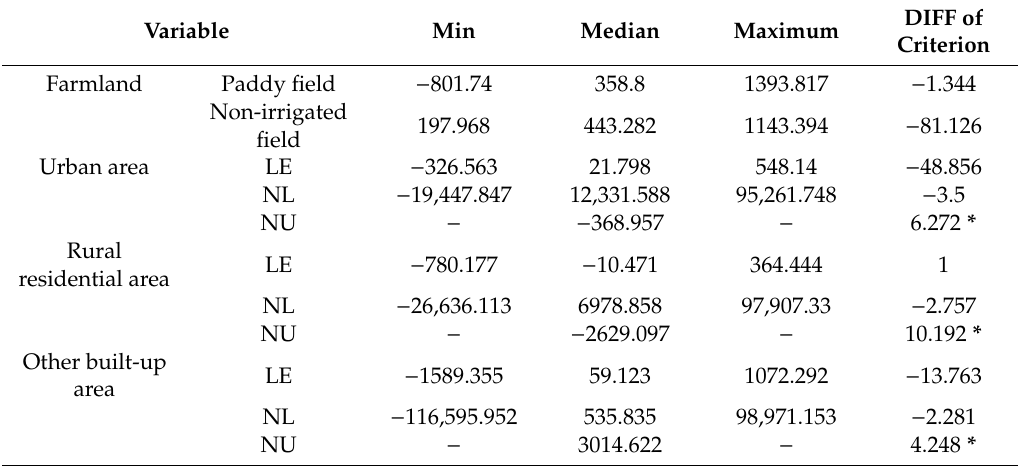
Table 3. Summary of semi-parametric, geographically weighted regression model (s-GWR) models and results of a geographic variability